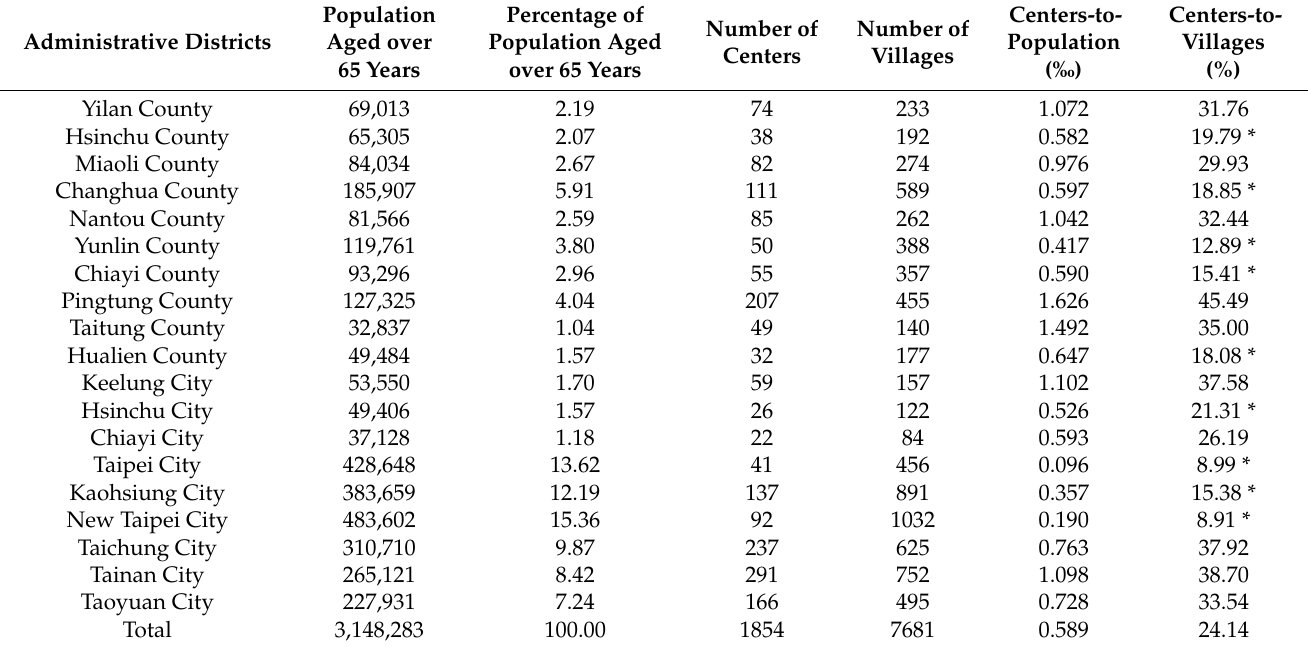
Table 2. Summary statistics for population aged 65+ or above and community care stations, measured by administrative district.